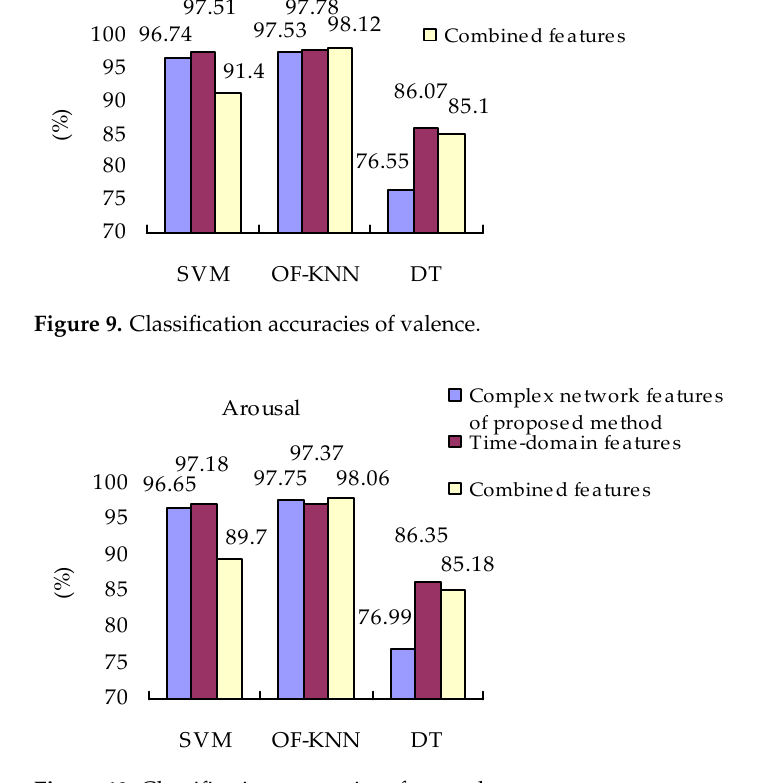
Figure 10. Classification accuracies of arousal.